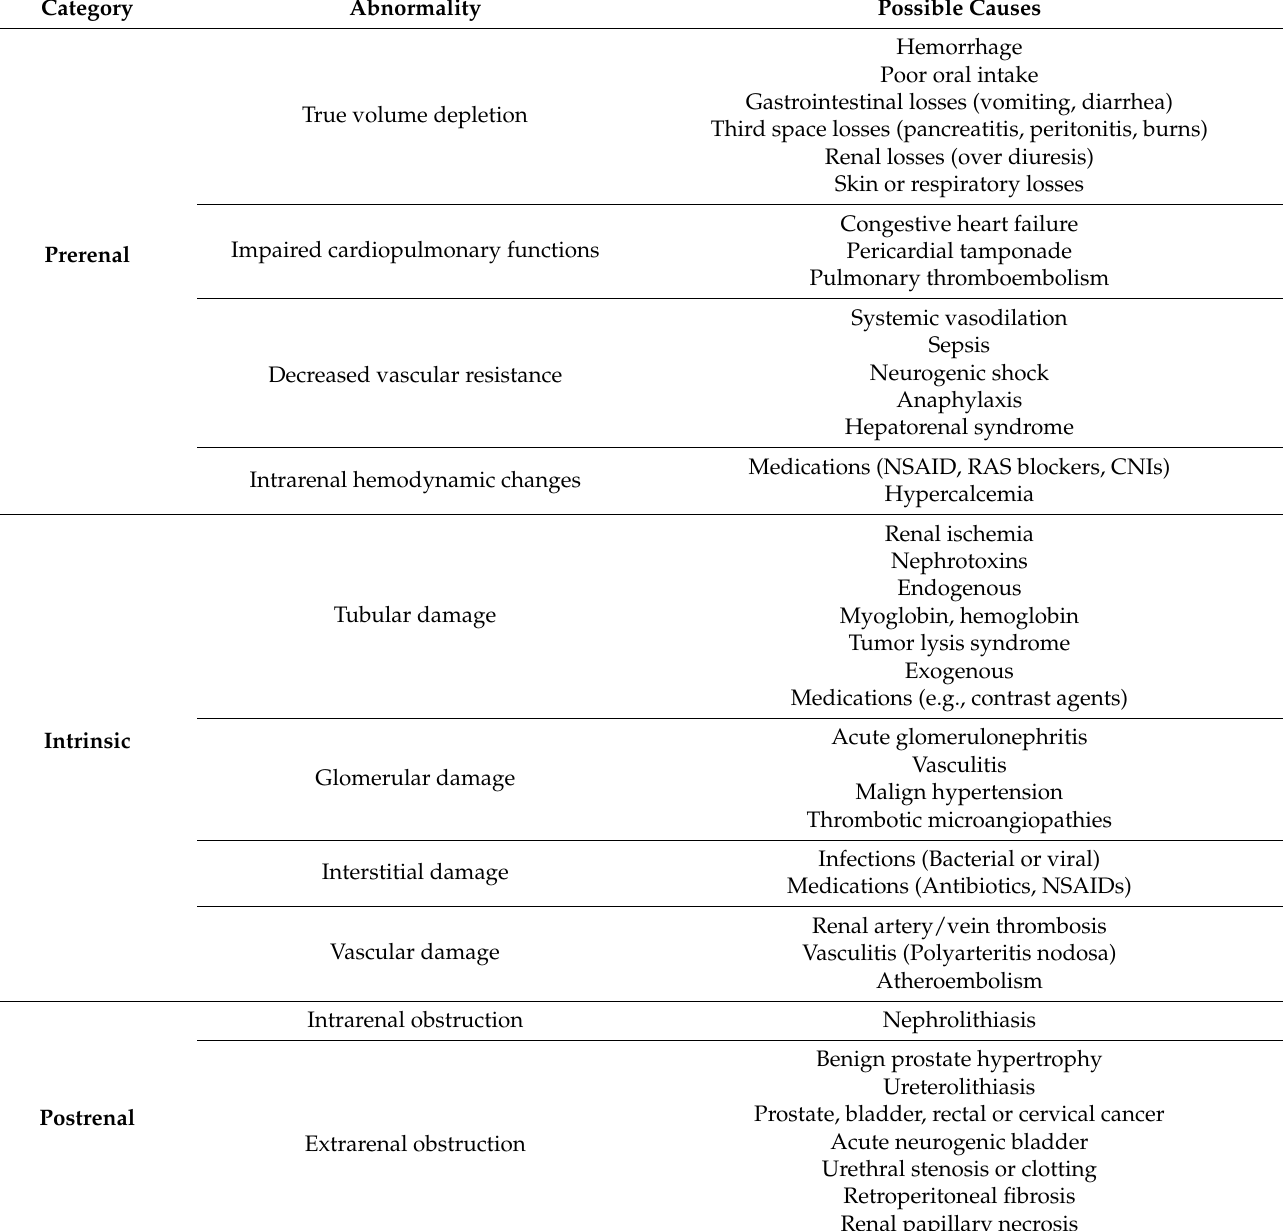
Table 1. Medical causes of acute kidney